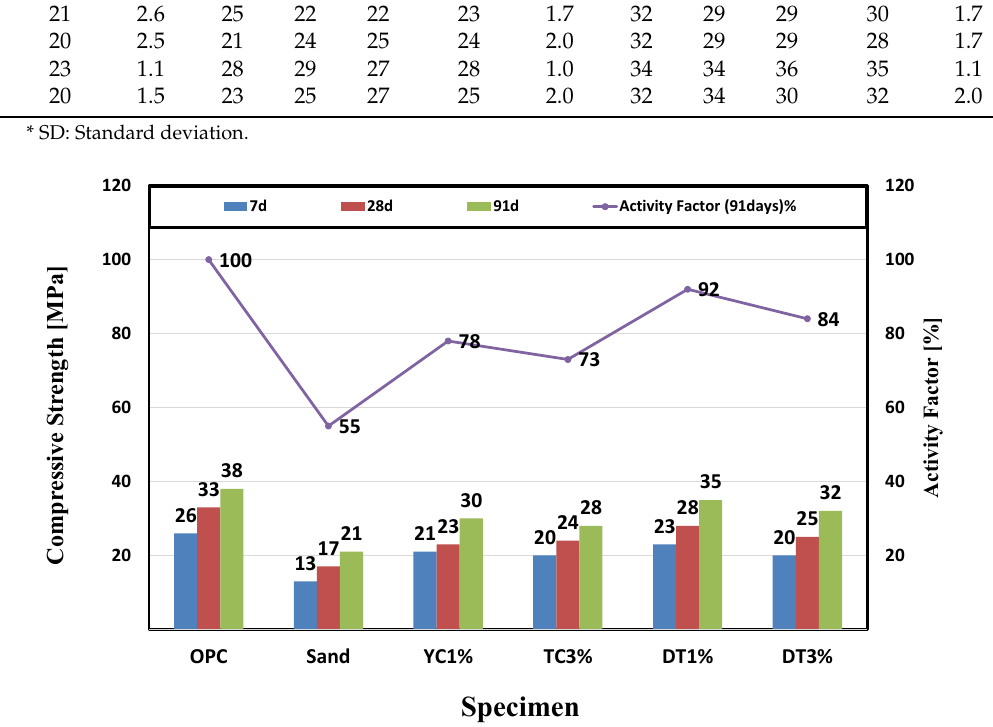
Figure 8. Measurement of Compressive strength and activity factor of the specimens.